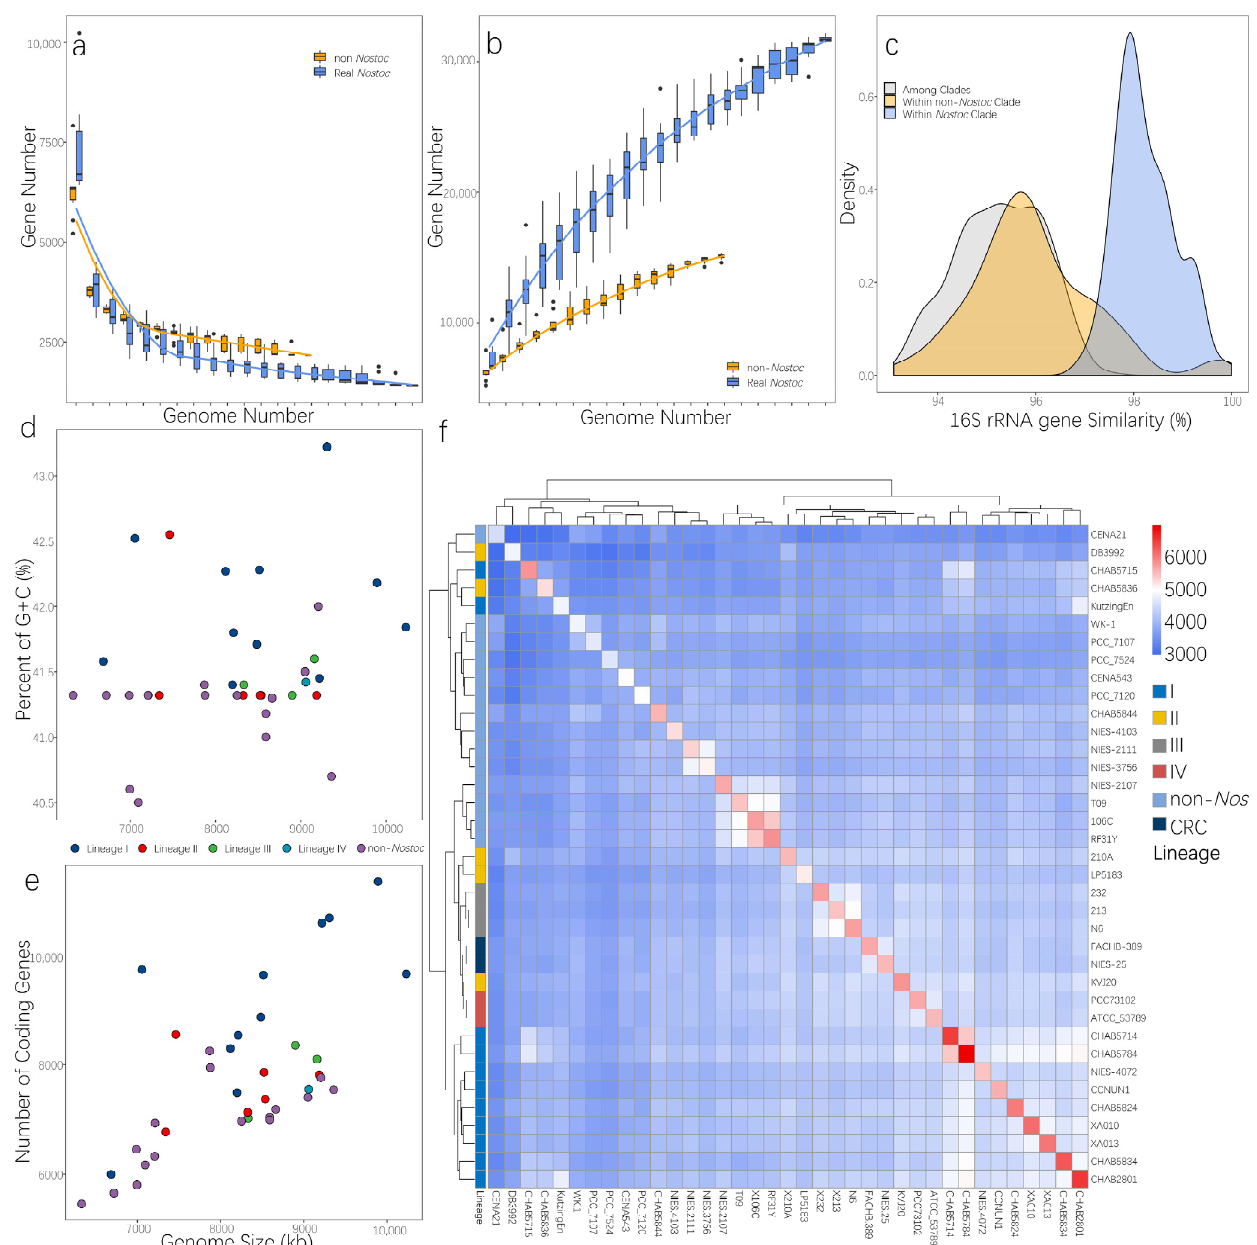
Figure 4. Comparison of genomic characteristics of RNS and non- Nostoc species. The core pan-genomes of RNS and non- Nostoc species were estimated. ( a ). Core genome. ( b ) . Pan-genome. ( c ) . Density plot of paired-wise comparison of 16S rRNA gene similarity. Comparison of ( d ) G + C ratio on each strain ( e ) genome size versus the number of coding genes. ( f ). Shared number of ortholog proteins of each strain. The strains with high similarity were clustered together via the hclust method. Each color lump on the rows represents the phylogenetic clade of each strain, and the clustering results were counted and plotted using the Pheatmap package in R [49].